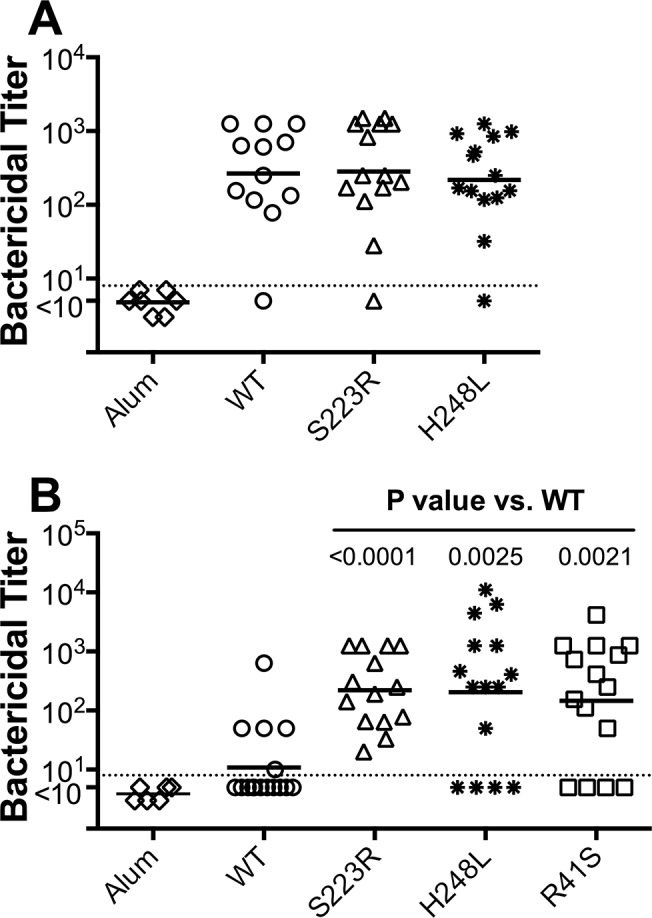
Serum bactericidal antibody responses of mice to mutant FHbp vaccines.
A. Control mice immunized with FHbp mutant vaccines. Each symbol represents the serum bactericidal antibody titer of an individual mouse and the horizontal lines represent the geometric mean titer (GMT) of each vaccine group. There were no statistically significant pairwise differences between the WT FHbp and either of the FHbp mutants (P≥ 0.62). B. Human FH transgenic mice immunized with FHbp mutant vaccines. The GMT for the R41S mutant was 13-fold higher than for the wild-type FHbp, 20-fold higher for S223R, and 19-fold higher for H248L. The P values for Mann-Whitney tests comparing each mutant group with the WT group are shown.